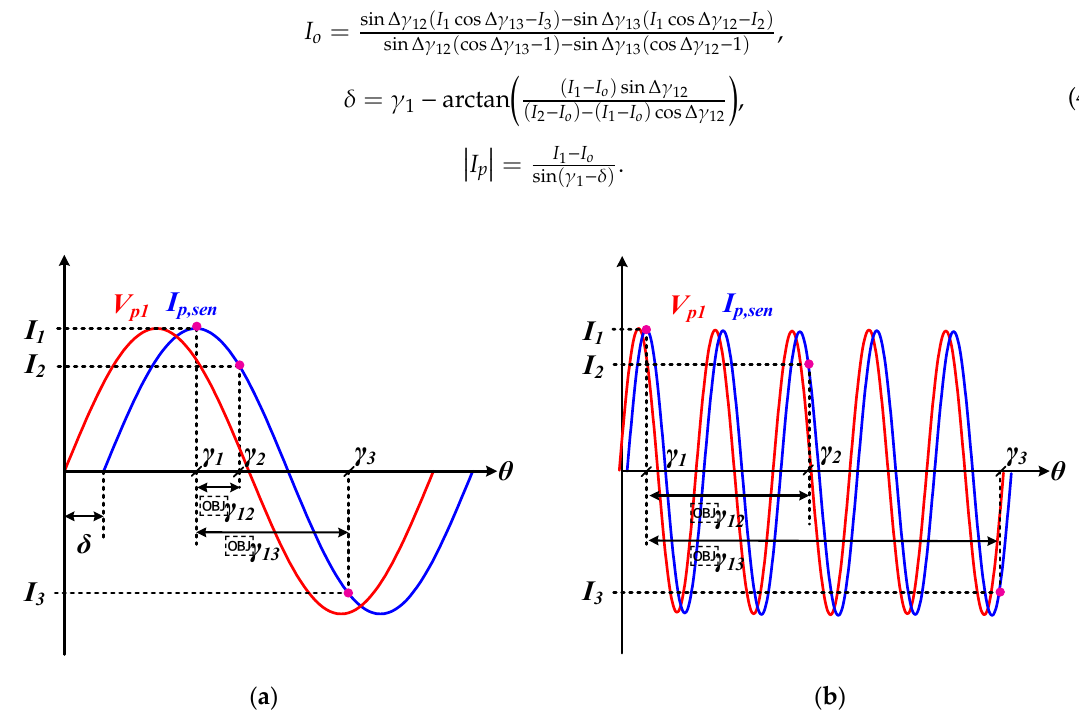
Figure 3. Example of sampling points of current waveform of ( a ) super-sampling, ( b ) sub-sampling. Table 1. Digital signal processor (DSP) utilization of each sampling method.